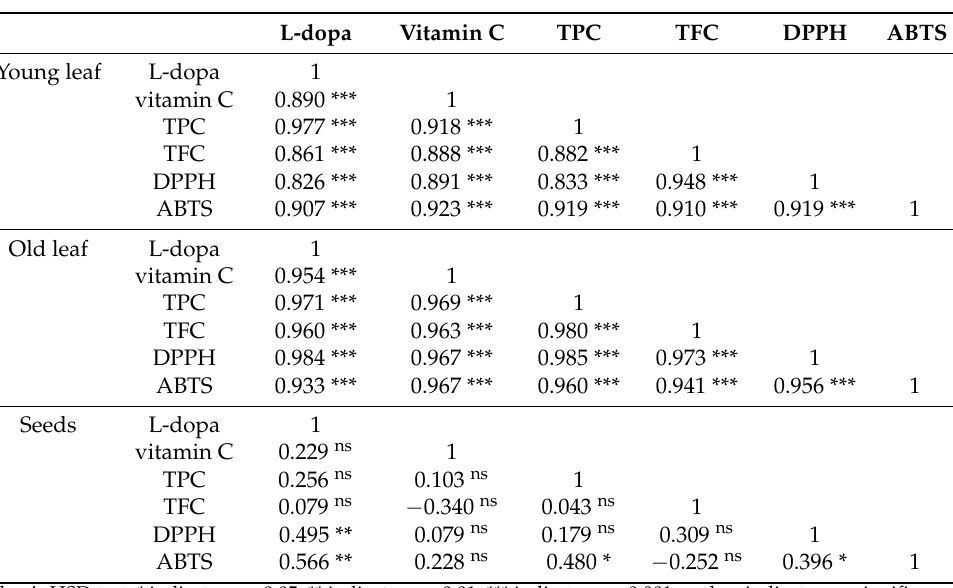
Table 2. Correlation coefficients between antioxidant activities and metabolite groups assembled with processed faba